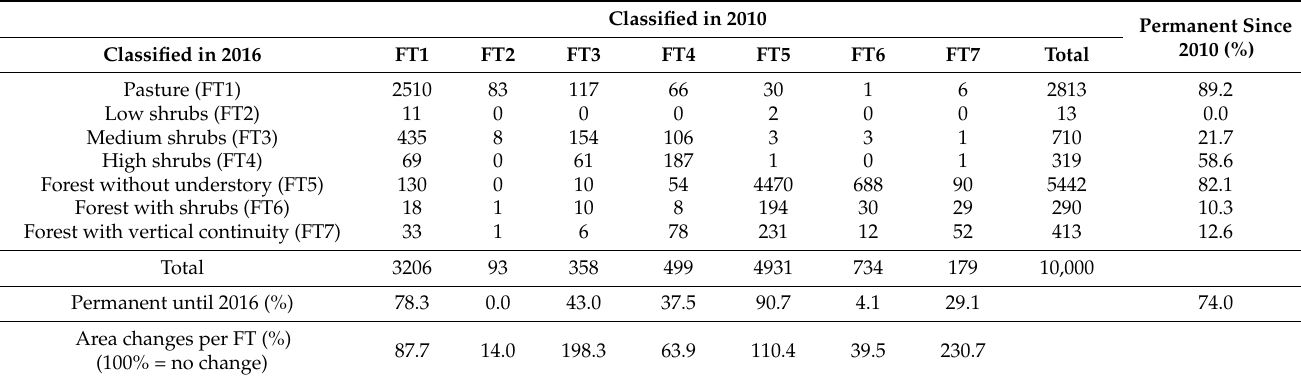
Table 5. Summary of the FT transitions between 2010 and 2016 with a pixel size of 20 m. Area changes per FT: proportion of area change per FT between 2010 and 2016 (%). Permanent since 2010: proportion of 2016 FT area that remained unchanged since 2010 (%). Permanent until 2016: proportion of 2010 FT area that remains unchanged until 2016